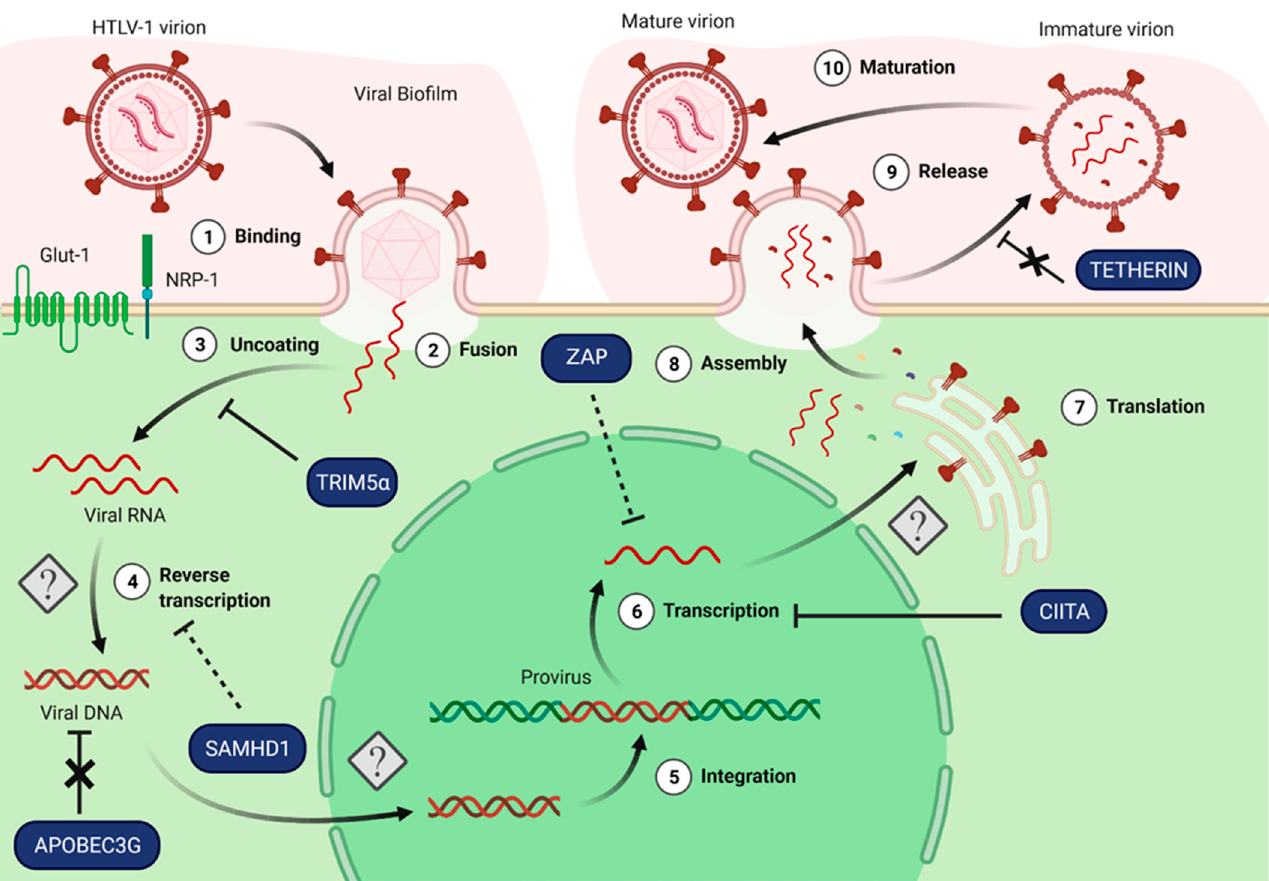
Figure 2. HTLV-1 viral replication cycle and restriction factors: knowledge and gaps. HTLV-1 viral replication cycle remains incompletely described, as indicated by the question marks. The model presented here relies on similarities with HIV viral replication cycle for steps remaining unresolved or not yet investigated. During early binding, HTLV-1 envelope proteins bind to NRP-1, Glut-1 and HSPG (not depicted) (1), which triggers conformational changes allowing fusion at the cell membrane (2). The two copies of the viral RNA genome are released in the cytoplasm (3) and converted into double-stranded DNA by the reverse transcriptase (4), although the exact sequence of events from uncoating to reverse transcription is not fully elucidated. After import of the viral dsDNA into the nucleus, a process that remains to be elucidated, viral DNA is integrated in the cellular genome by the viral integrase (5). During the late steps, the proviral genome is transcribed (6), viral mRNA are spliced and translated into viral proteins (7). These processes are not completely understood, but the HTLV-1 viral proteins Tax and Rex are known to control transcription and export of unspliced mRNA, respectively. Eventually, viral RNA and proteins assemble to form new viral particles (8) budding from the cell membrane and released as immature particles (9) that are later matured by viral protease cleavages (10). The antiviral activities of known restriction factors active against HIV (blue blocks) have been tested in the context of HTLV-1 infection. While some restriction factors such as TRIM5 α and CIITA are able to restrict the HTLV-1 replication cycle to some extent, others are inefficient (APOBEC3G and Tetherin), or show a controversial activity on HTLV-1 (SAMHD1) or not fully described (ZAP) activity on